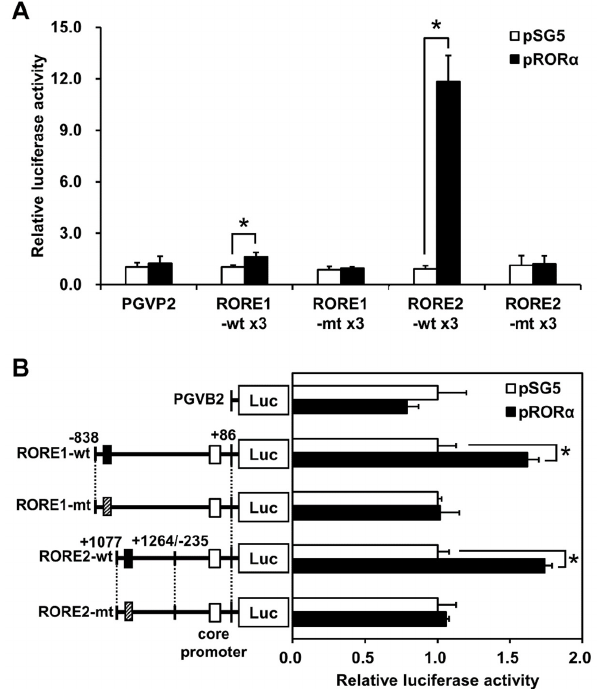
Figure 2. RORα induces CYP39A1 expression by directly interacting with ROREs of the